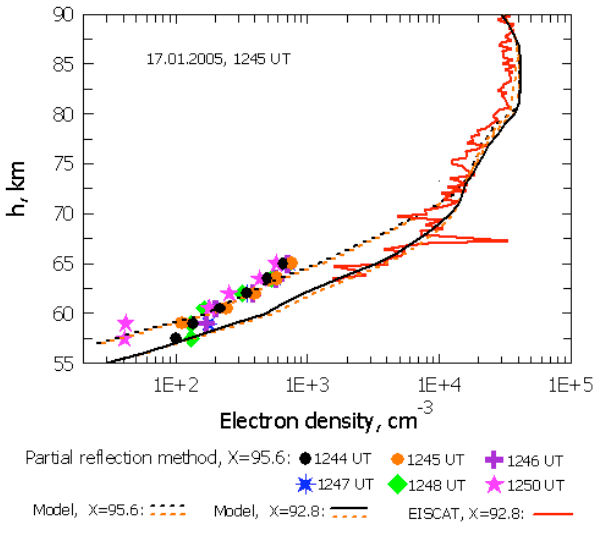
Fig. 5b. Electron density profiles measured (red curve and sym- bols) and calculated for the SPE on 17 January 2005 at 12:45UT for zenith angles 92.8 ◦ and 95.6 ◦ using the O, O 3 and NO profiles 4–6 in Fig. 1 (black curve) and using the O, O 3 and NO profiles 1–3 in Fig. 1 (red dashed curve).